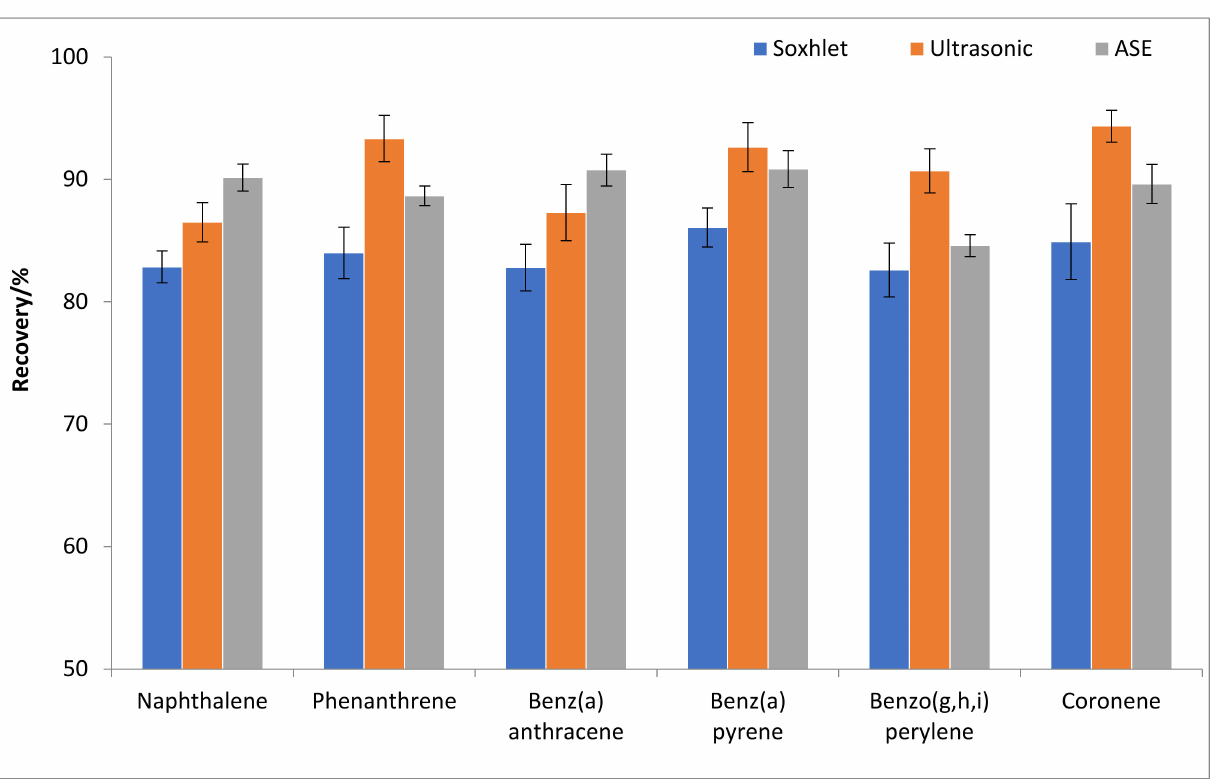
Figure 2. The extraction recoveries of selected PAHs using three different methods including Soxhlet extraction, ultrasonic extraction, and accelerated solvent extraction